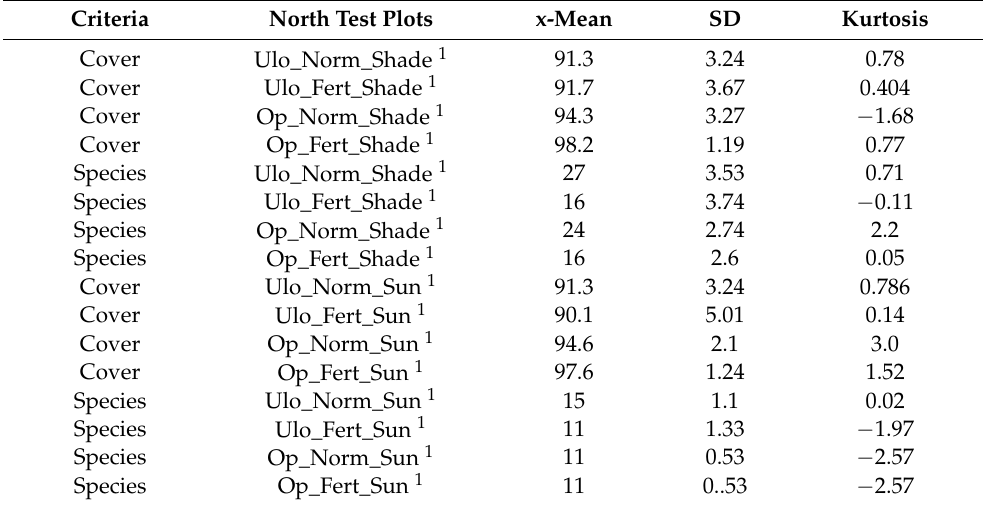
Table 14. Greening with vegetation mats, n = 9 years, from 2011 to 2020. Coverage and number of species for the test plots with fertilizer (Fert.) and without (Norm.) of the northern position; mean value, standard deviation, and kurtosis. Shade: in the shade of an elevated section of the roof.